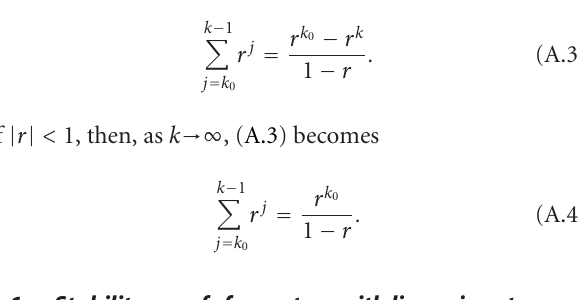
Figure 3. During availability time intervals T a